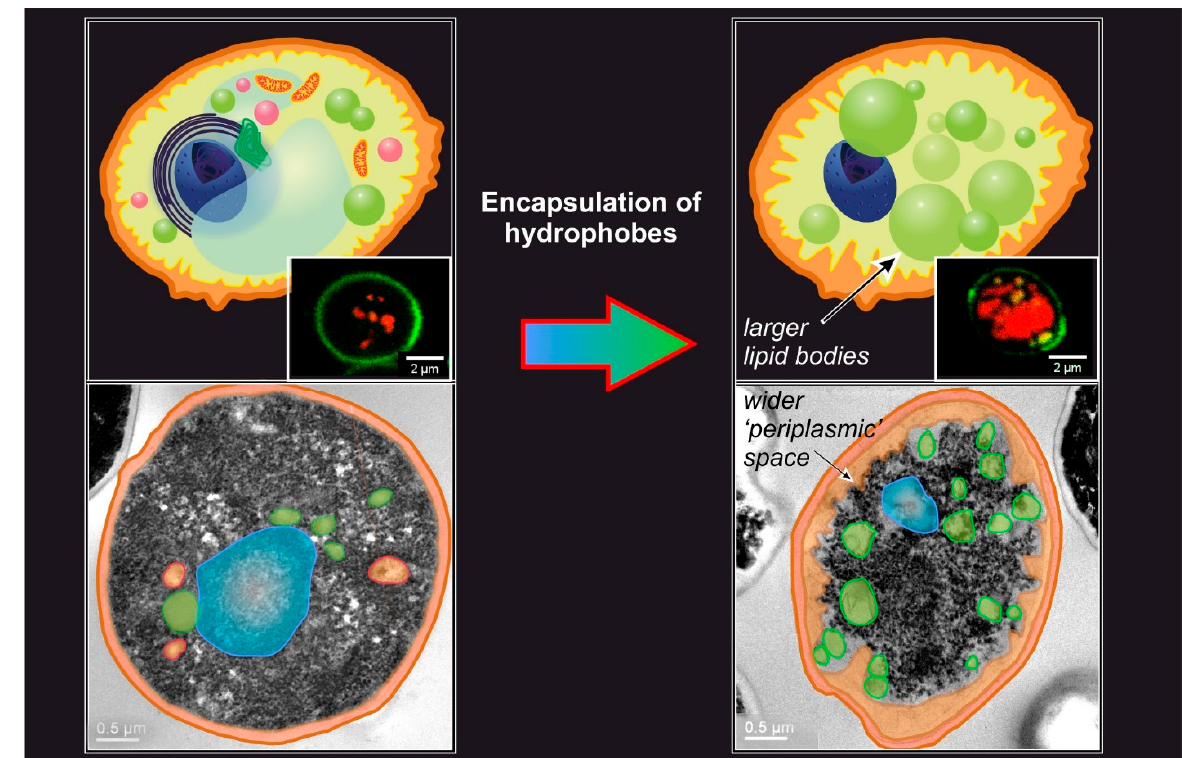
Figure 3. The yeast ultrastructure is dramatically altered by the encapsulation of hydrophobes; the TEM and confocal pictures show encapsulation in intact cells (limonene, 30% in relation to yeast dry weight, T = 60 °C, 4 h), but permeabilized cells behave similarly. The most striking result is the large increase in the number and dimensions of bodies that can be colored by the lipid stain Nile Red (in the insets, confocal images where the cell wall is stained by Concanavalin A, and Nile Red fluorescence highlights the lipidic bodies). However, as can be noted in the TEM images below, upon encapsulation of hydrophobes, the ‘periplasmic’ space (highlighted in light orange both in schemes and images) greatly increases; it is indeed difficult to define this area accurately, because the cell membrane has disappeared, but at this point, this is an area located between the wall and residual cytoplasmic content/lipid bodies (which localize predominantly in the center of the cell body, see inset on the right). Importantly, cytoplasm organization becomes more granular and—bar the lipidic bodies and the nucleus—hardly any organelle is recognizable. TEM images are courtesy of Federico Catalano, IIT Electron Microscope Imaging Facility (Genova, Italy).